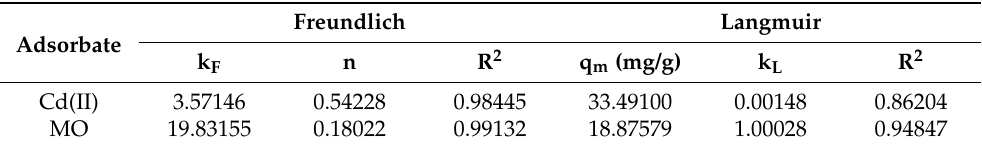
Figure 4. Fitting of adsorption isotherms of Cd(II) ( a ) and MO ( b ); Fitting of adsorption kinetics of Cd(II) ( c ) and MO ( d ); Fitting of intra-particle diffusion models of Cd(II) ( e ) and MO ( f ) by BNT-MBC (adsorbent dose 20 mg, contaminant solution 10 mL, pH 6, constant temperature 25 ◦ C, and reaction time 24 h). Table 3. Fitting parameters of adsorption isotherm eith